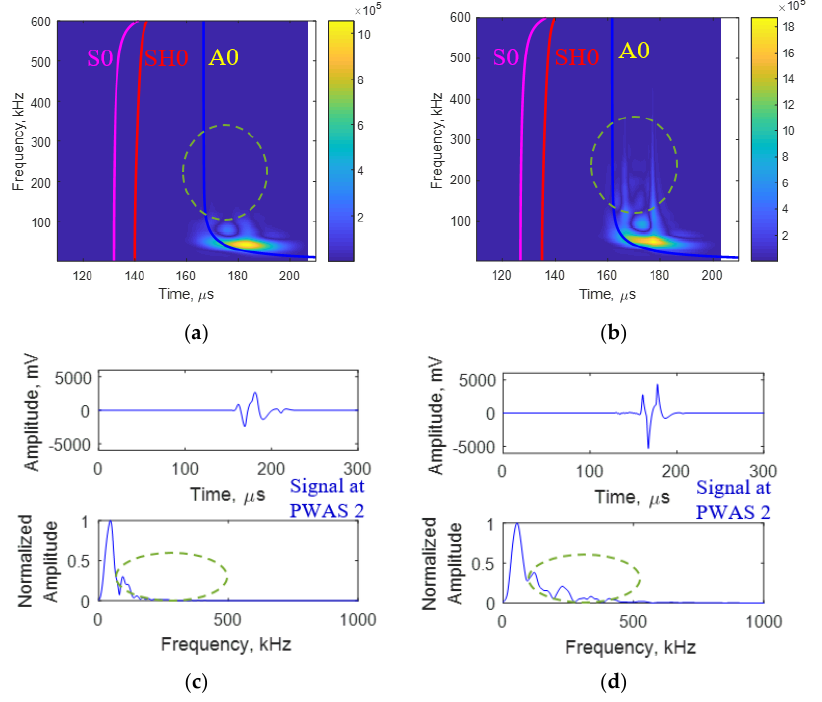
Figure 16. ( a ) Time-frequency plot from 1 J impact hit signal ( b ) Time-frequency plot from 16 J impact hit signal ( c ) AE signal at PWAS 2 due to 1 J impact hit and frequency spectrum ( d ) AE signal at PWAS 2 due to 16 J impact hit and frequency spectrum.